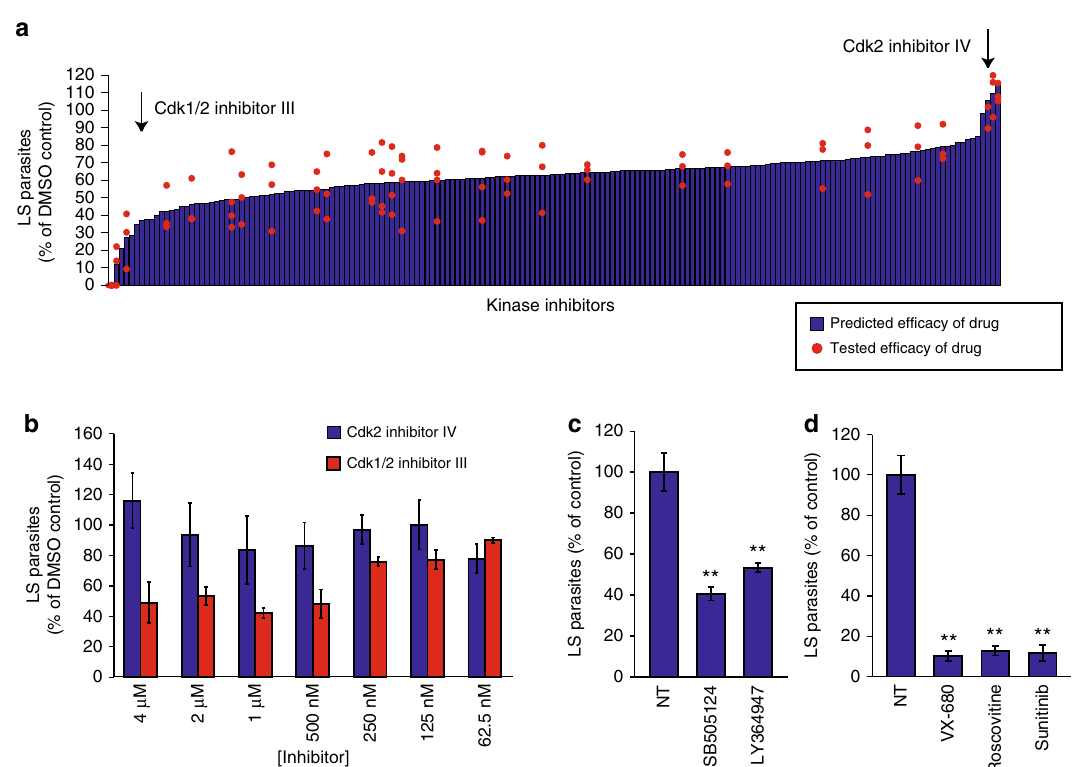
Fig. 4 Computational prediction of effective host-based drugs against Plasmodium yoelii infection. a Bar graph depicting predicted ef fi cacy of host-targeted kinase inhibitors in eliminating LS parasite burden. Independent experimental data measuring LS inhibition from drugs used to generate the training dataset are overlaid as data points onto the bar graph. Red arrows indicate predicted ef fi cacies of two drugs against the same kinase target — CDK2. b 150,000 Hepa 1 – 6 cells were infected with 50,000 P. yoelii parasites and then treated with CDK2 inhibitors at different concentrations ranging from 4 μ M to 62.5 nM at 1.5 h.p.i. LS burden was evaluated by microscopy at 24 h.p.i. c 150,000 Hepa 1 – 6 cells were infected with 50,000 P. yoelii parasites and then treated with 500 nM of TGFBR-1 inhibitors SB505124 or LY364947 at 1.5 h.p.i. LS burden was evaluated by microscopy at 48 h.p.i. ** p ≤ 0.01 evaluated by Student ’ s two-tailed t -test. d 150,000 Hepa 1 – 6 cells were infected with 50,000 P. yoelii parasites and then treated with 500 nM VX-680, Roscovitine or Sunitinib at 1.5 h.p.i. Parasite burden was evaluated by microscopy at 24 h.p.i. ** p ≤ 0.01 evaluated by Student ’ s two-tailed t -test. All data are representative of at least three independent experiments. Error bars represent standard deviation of analytical